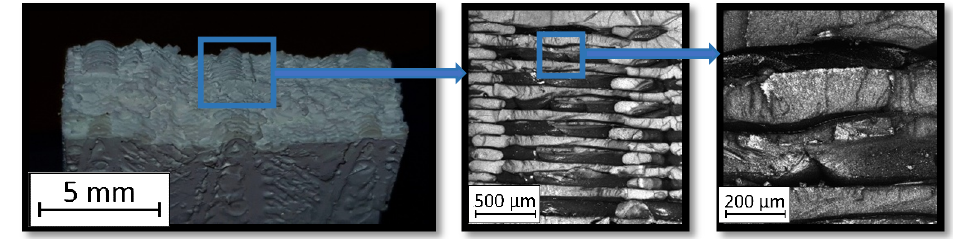
Figure 13. Fracture images of a pleated joint of PLA-ABS materials.